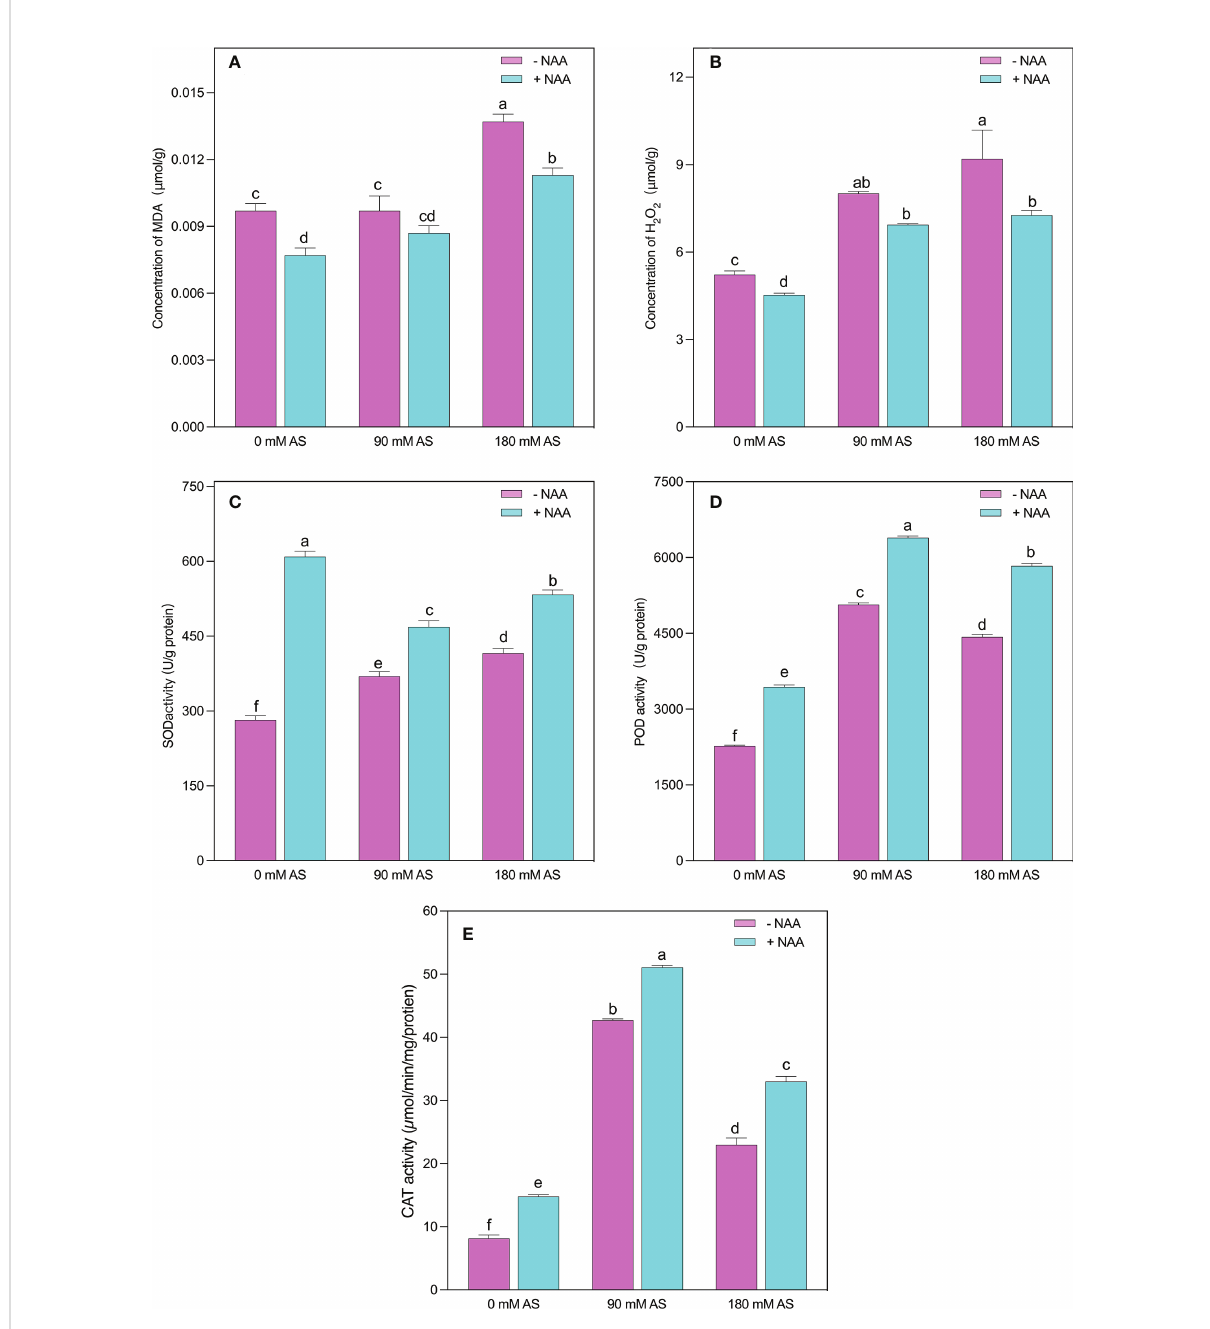
FIGURE 4 Changes in concentrations of (A) MDA (B) H 2 O 2 and enzymatic activity of (C) SOD (D) POD, and (E) CAT in chufa plants under alkaline stress (AS) and exogenous naphthaleneacetic acid (NAA)application. Bars represents SD of mean, n=3. Different letters indicate signi fi cantly different values at P <0.05 (Duncan ’ s